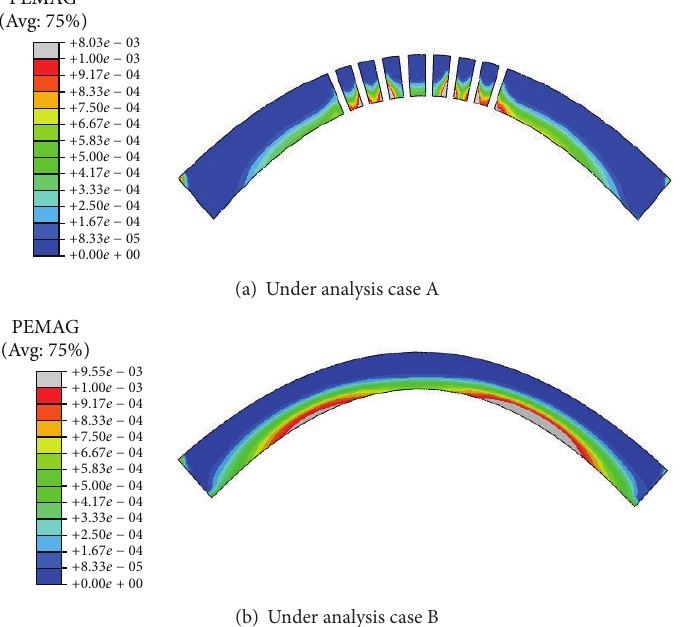
Figure 11: Plane section of yield zone in middle outlets under various analysis cases (6 times overloading).